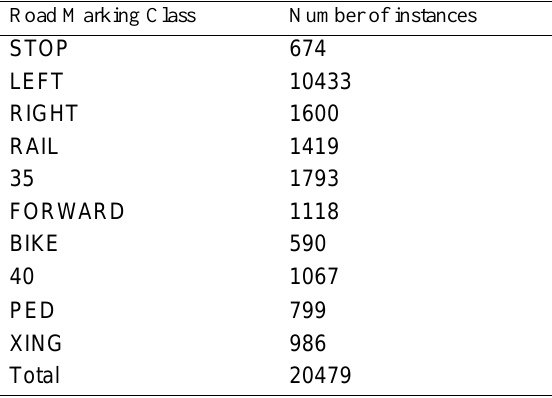
Table 2. Dataset resulting from data